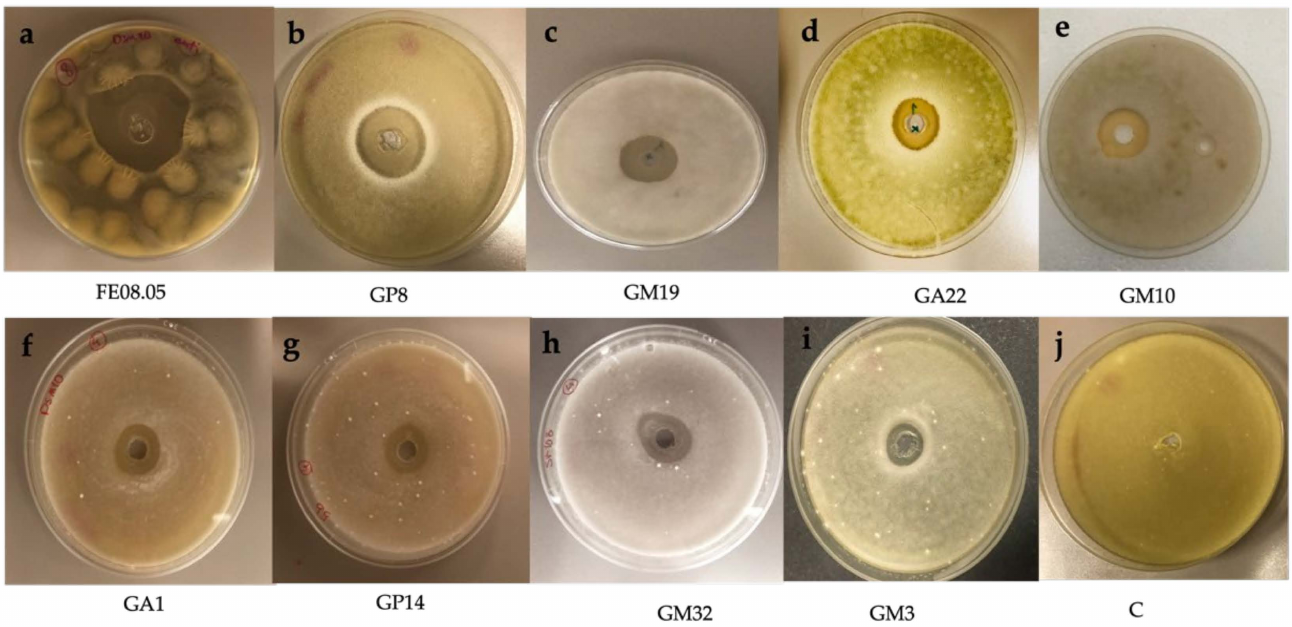
Figure 4. Mycelial growth inhibition of 9 different isolated yeast on Botrytis cinerea . ( a ) Starmerella bacillaris FE08.05, ( b ) Metschnikowia pulcherrima GP8, ( c ) Hanseniaspora uvarum GM19, ( d ) Hanseniaspora opuntiae GA22, ( e ) Hanseniaspora opuntiae GM10, ( f ) Hanseniaspora guilliermondii GA1, ( g ) Hanseniaspora pseudoguilliermondii GP14, ( h ) Hanseniaspora lanchancei